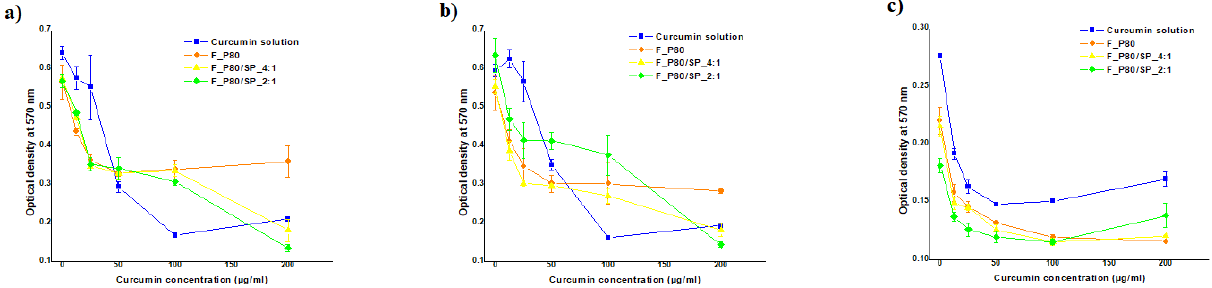
Figure 9: Optical density of the cell cultures after the treatment by the investigated samples: a) MRC-5 cell line; b) Fem-X cell line; c) HeLa cell line. Cells were incubated with several concentrations of the curcumin nanocrystal dispersions and curcumin solution After 48 hours of incubation, MTT reagent was added. Obtained data show optical density of the cell cultures (570 nm) for the selected sample concentra- tions. Each experiment was repeated three times and the results were presented as the mean value ±